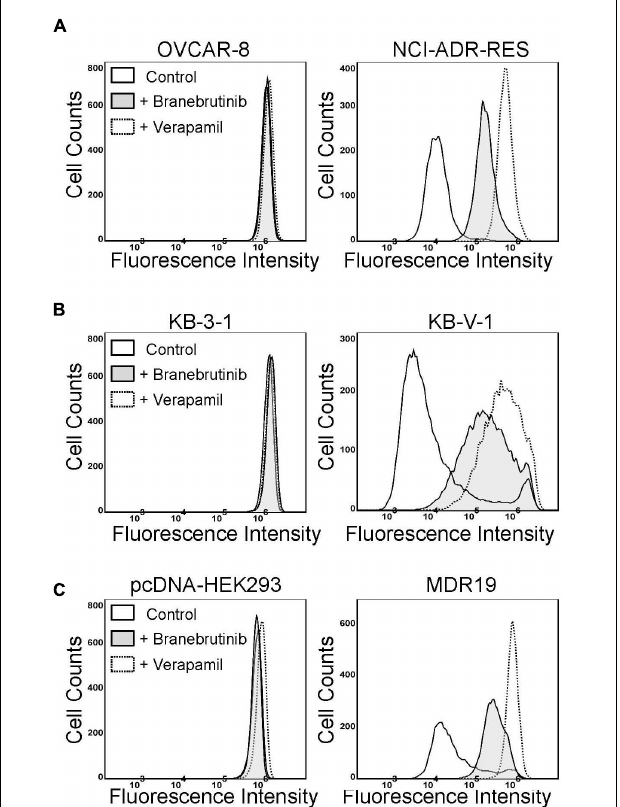
FIGURE 2 | Branebrutinib inhibits P-glycoprotein (P-gp)-mediated drug efflux. The effect of branebrutinib on the intracellular accumulation of calcein, a fluorescent product of a known P-gp substrate calcein-AM, was determined in (A) OVCAR-8 (left panel) and NCI-ADR-RES cancer cells (right panel); (B) KB-3-1 (left panel) and KB-V-1 (right panel); and (C) HEK293 cells (left panel) and P-gp-transfected MDR19-HEK293 cells (right panel). Cells were treated with DMSO (control, solid lines), 20 µ M of branebrutinib (filled solid lines) or 20 µ M of a reference inhibitor verapamil (dotted lines) as a positive control. The fluorescence signal was analyzed by flow cytometry as described previously (Wu et al., 2007). Representative histograms of at least three independent experiments are